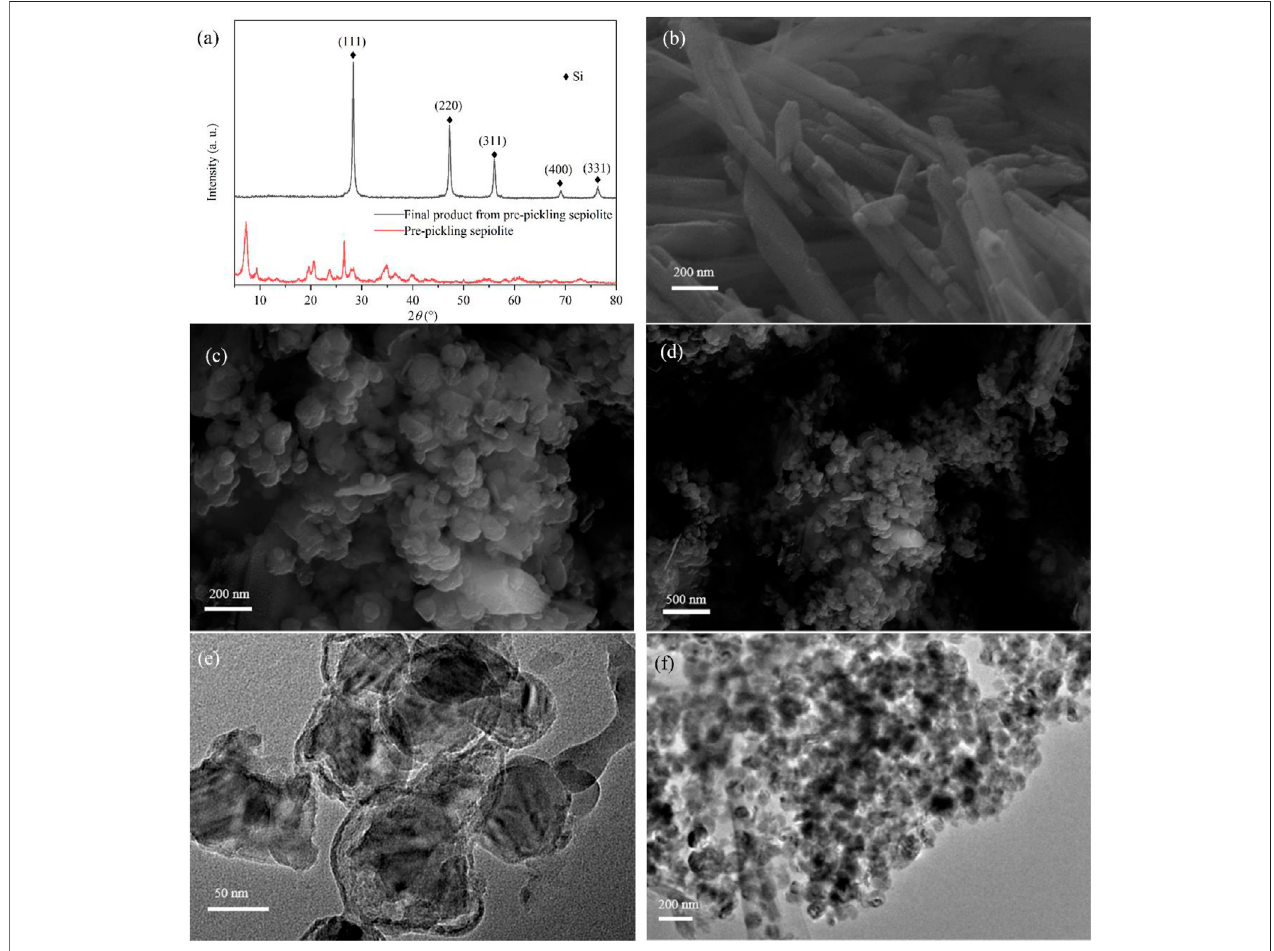
FIGURE 4 | (A) XRD patterns of pre-pickling sepiolite and fi nal product from pre-pickling sepiolite. (B) SEM of pre-pickling sepiolite showing 1D nano fi ber morphology. (C,D) SEM and (E,F) TEM of the fi nal product showing nanosphere morphology.